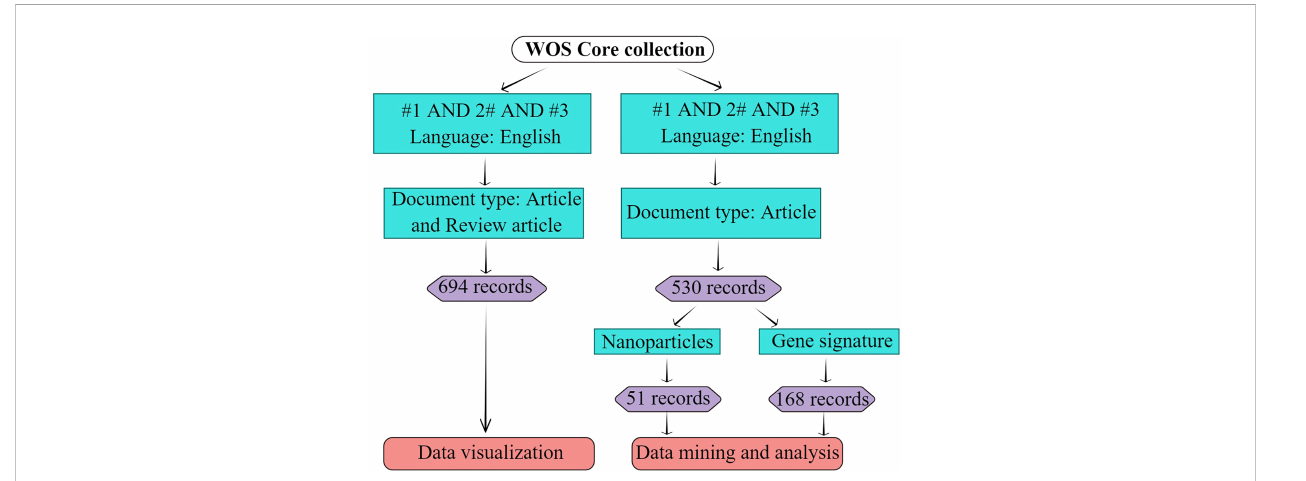
FIGURE 2 Search strategy. #1 represents “ (((((((((TS=(anti-tumor immunity)) OR TS=(immunity)) OR TS=(cancer immunotherapy*)) OR TS=(anti-tumor immunotherapy*)) OR TS=(immune therapy*)) OR TS=(anti-tumor immune therapy*)) OR TS=(immunology therapy*)) OR TS=(anti-tumor immunology therapy*)) OR TS=(Radioimmunotherapy*)) OR TS=(Immunomodulation) ” ; #2 represents “ TS=(Neoplasm* or cancer$) ” ; #3 represents “ TS=(ferropto*) ” ; “ * ” represents in fi nite truncator; “ $ ” represents fi nite truncator; the retrieval date was Feb 10 th , 2023. This fi gure was drawn by Figdraw of HOME for